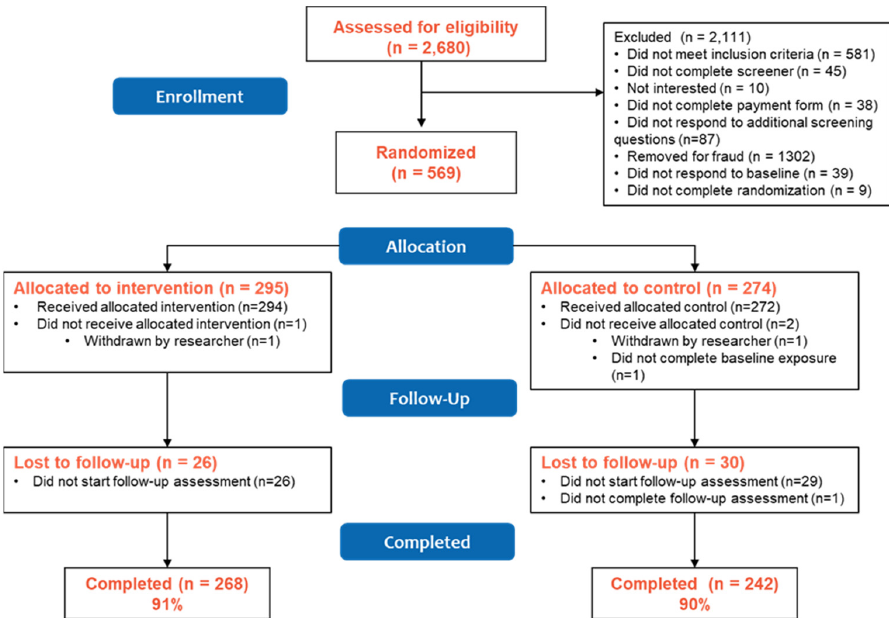
Figure 1. PACE Vape Messaging Study CONSORT Diagram. Table 1. Sample characteristics, PACE Vape Messaging Study,